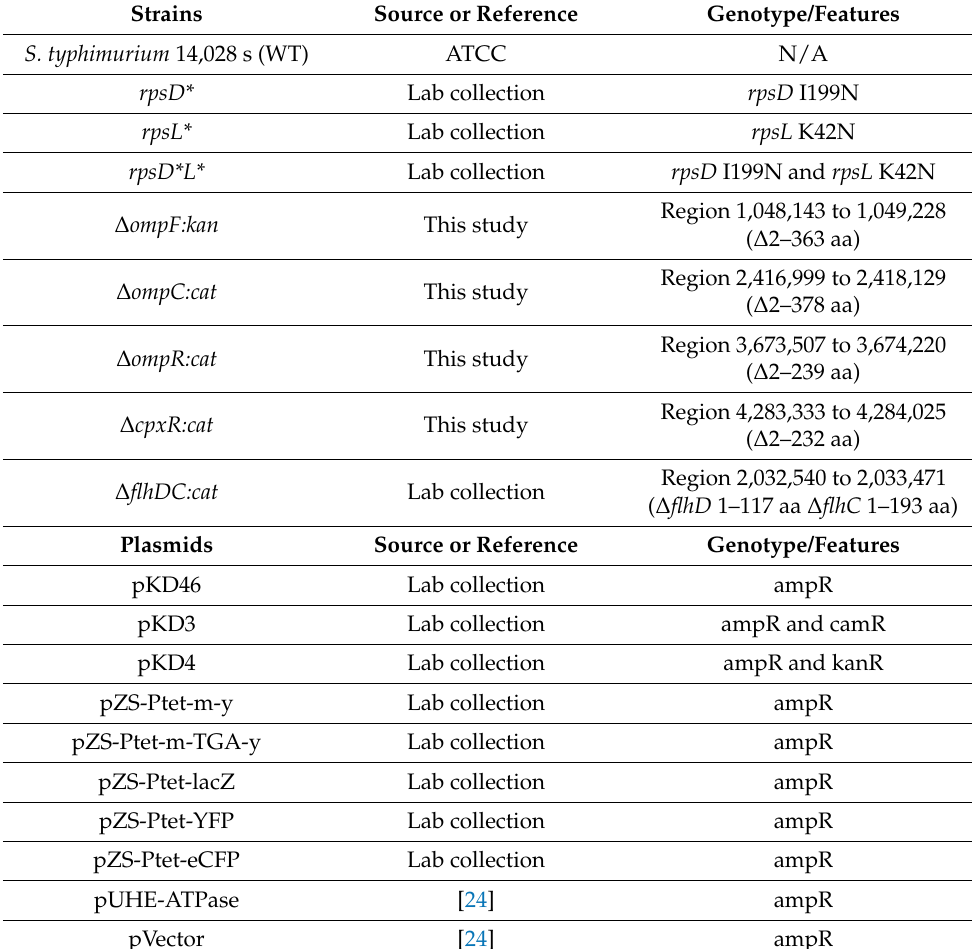
Table 1. Strains and Plasmids used in this